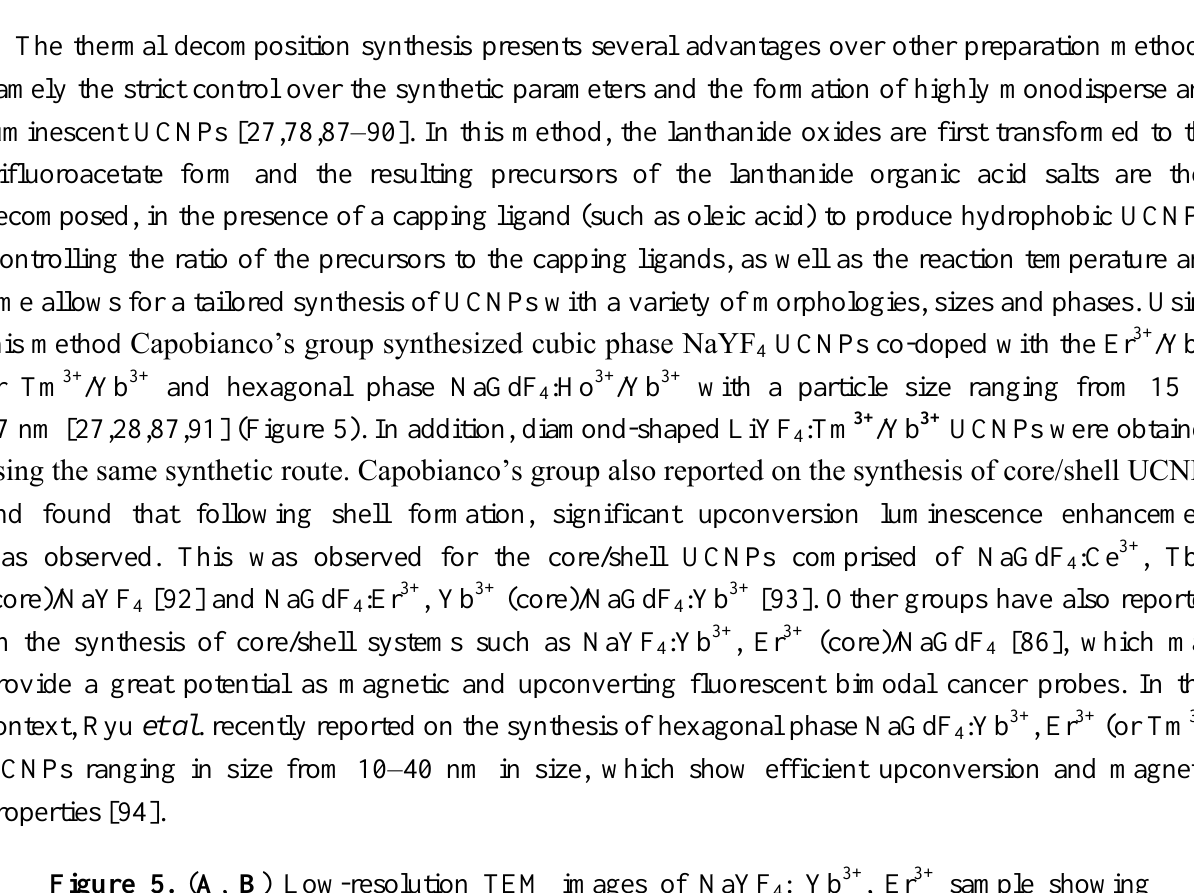
: Yb 3+ , Er 3+ sample showing 4 :Yb 3+ 4